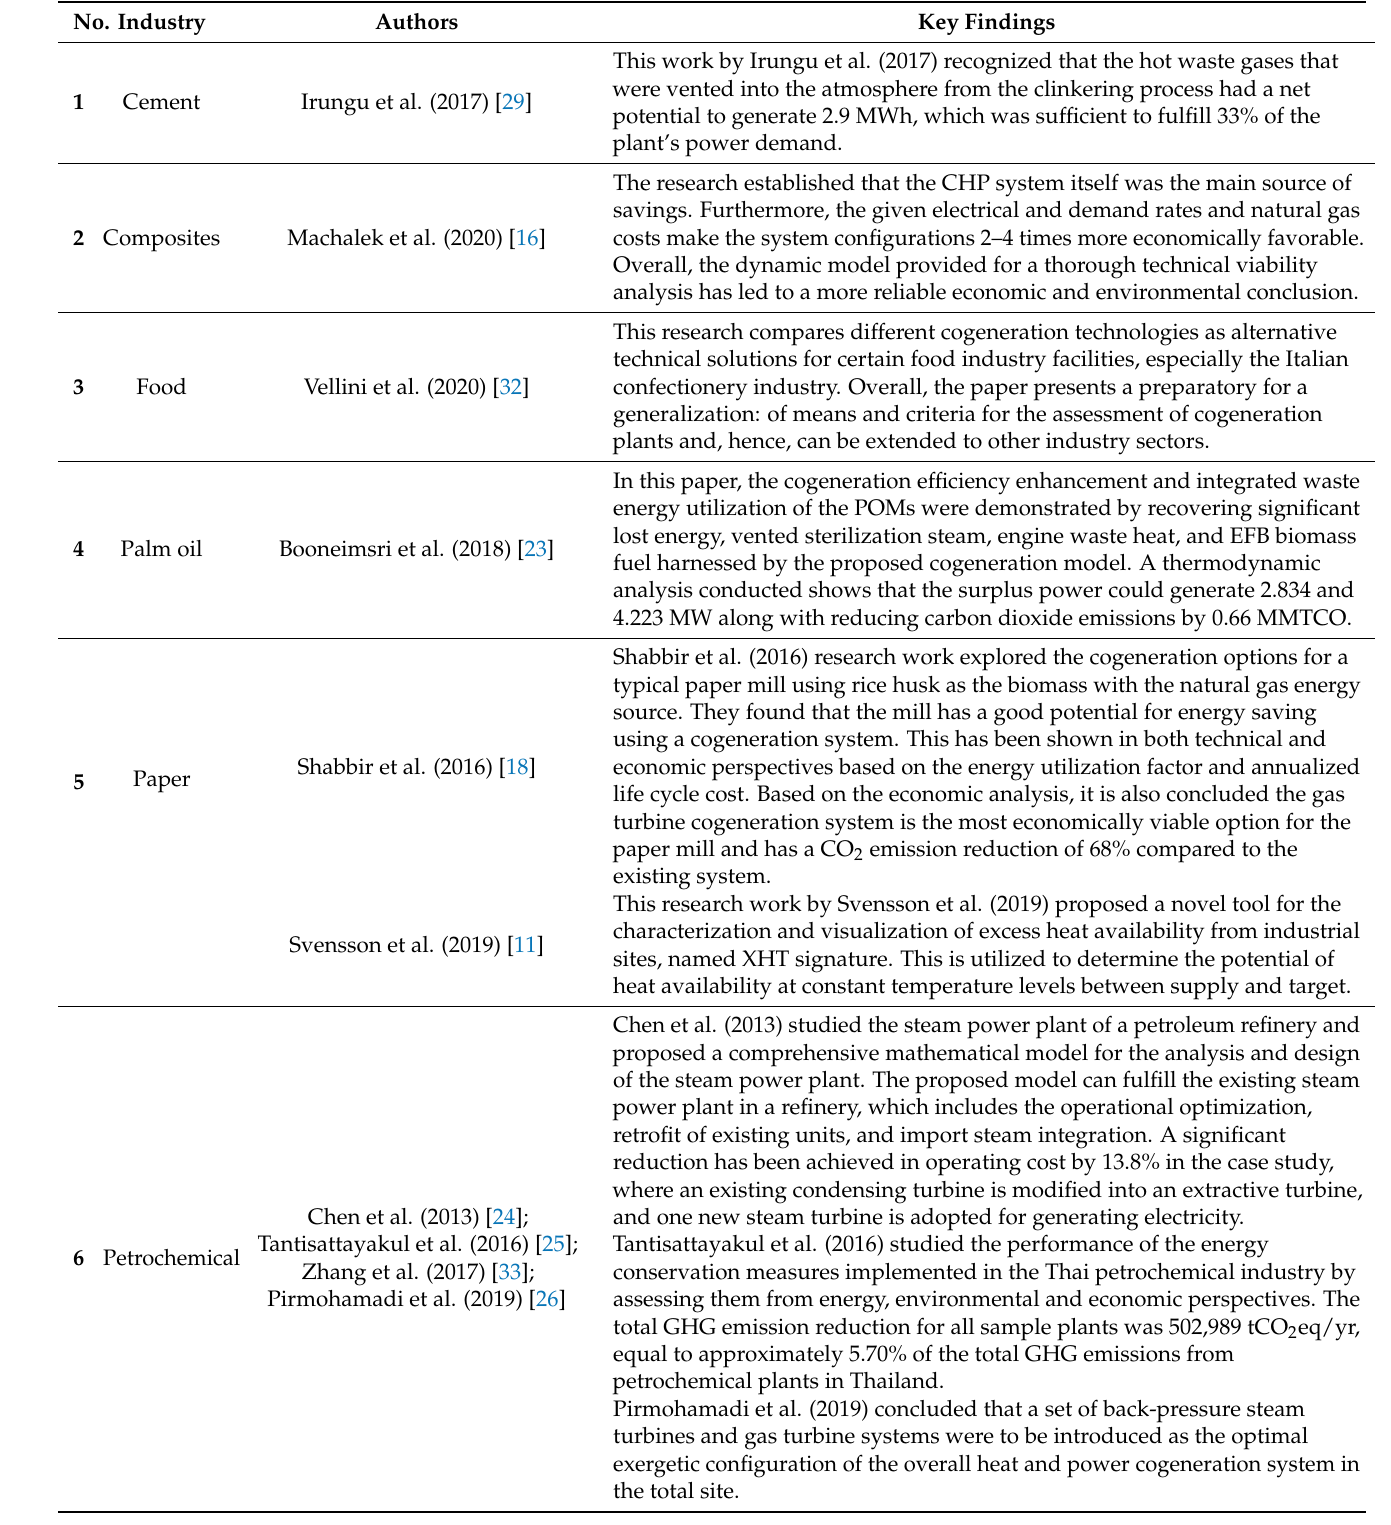
Table 1. Example case studies by